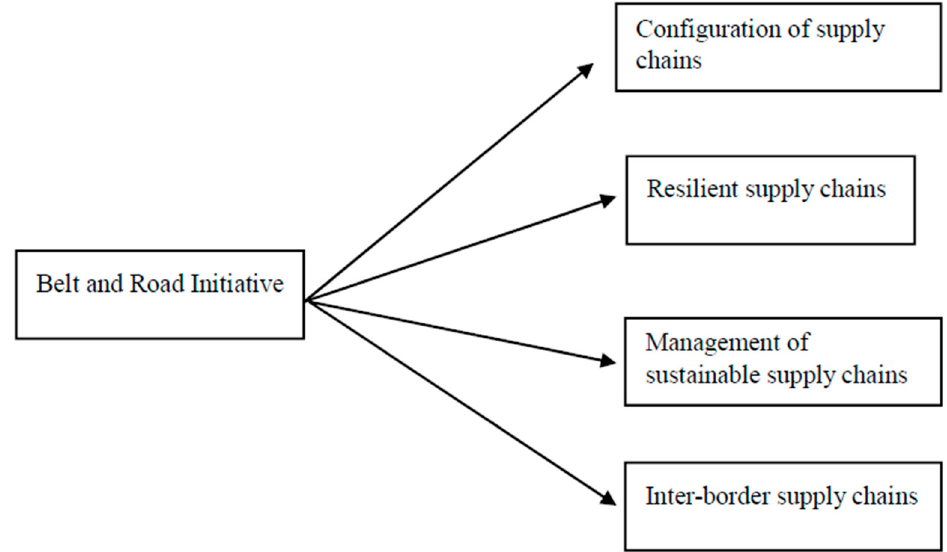
Figure 1. Conceptual framework of the implications of the Belt and Road Initiative (BRI) on supply chain management.